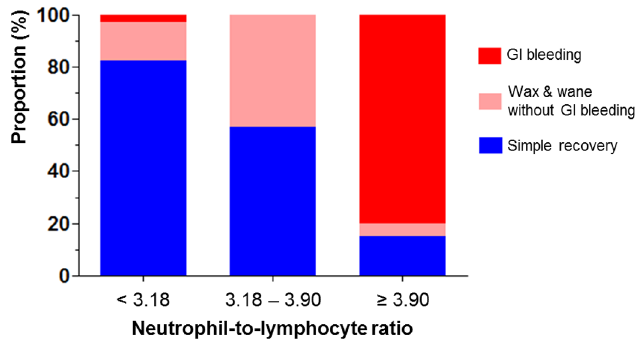
doi:10.1371/journal.pone.0153238.g003